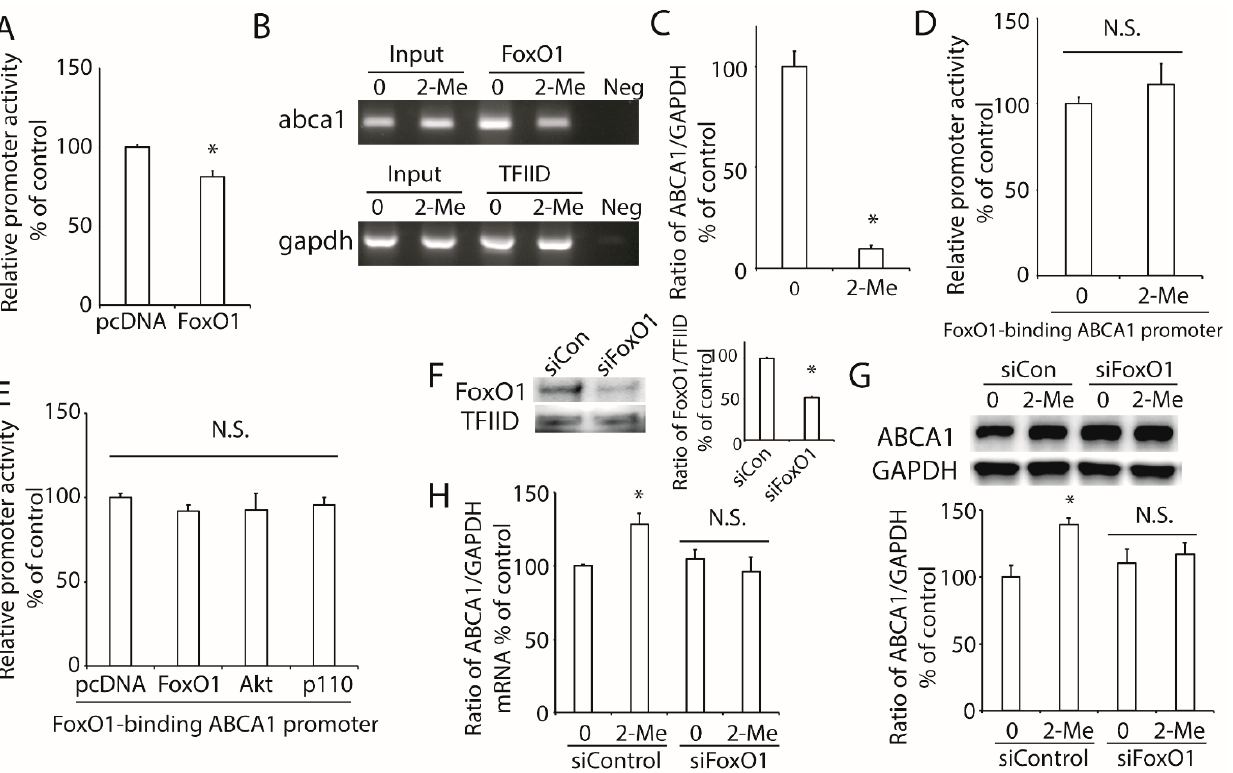
Figure 5. Role of FoxO1 in 2-ME 2 -mediated ABCA1 transcription in HepG2 cells. ( A ) Effect of FoxO1 on ABCA1 promoter activity. ( B ) Binding of FoxO1 to the ABCA1 promoter region. FoxO1 specifically immunoprecipitates ABCA1 chromatin by the ChIP assay. No ChIP was detected when the chromatin was immunoprecipitated with an unspecific negative control IgG (IgG). ( C ) ChIP-real time PCR showed that 2-ME 2 reduced the binding of FoxO1 to ABCA1 promoter. ( D ), Effect of 2-ME 2 on FoxO1-binding sites-mutated promoter activity (5 ′ -AACA-3 ′ to 5 ′ -GGAG-3 ′ ). ( E ) Effect of FoxO1, Akt, or p110 on FoxO1-binding sites-mutated promoter activity. ( F ) Expression of nuclear FoxO1 after silencing FoxO1 with specific siRNA. ( G , H ) Effect of 2-ME 2 on the protein ( G ) and mRNA ( H ) expression of ABCA1 after silencing FoxO1. siCon, scramble siRNA; siFoxO1, FoxO1-specific siRNA. Each data point shows the mean ± SEM ( n = 3) of separate experiments for each group. * p < 0.05 compared to 0; N.S., no significant